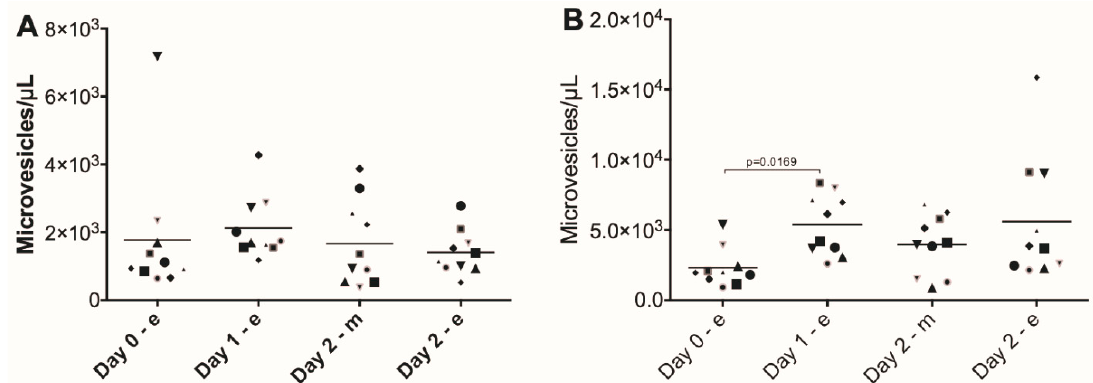
Figure 4. RBC-derived and platelet-derived microvesicles in the blood of participants in the Nijmegen Four Days Marches . ( A ) Concentration of RBC-derived microvesicles (ANOVA main effect p > 0.05); ( B ) concentration of platelet-derived microvesicles (ANOVA main effect p = 0.0169). Microvesicles were isolated from the blood of Four Days Marches participants and their concentrations were measured using RBC-specific and platelet-specific markers as described in Materials and Methods (N = 10). Aggregation and deformability are key characteristics of RBC function [25]. Participation in the Four Days Marches induced a decrease in RBC aggregation after the first day, and an increase in deformability after two days (Figure 5).